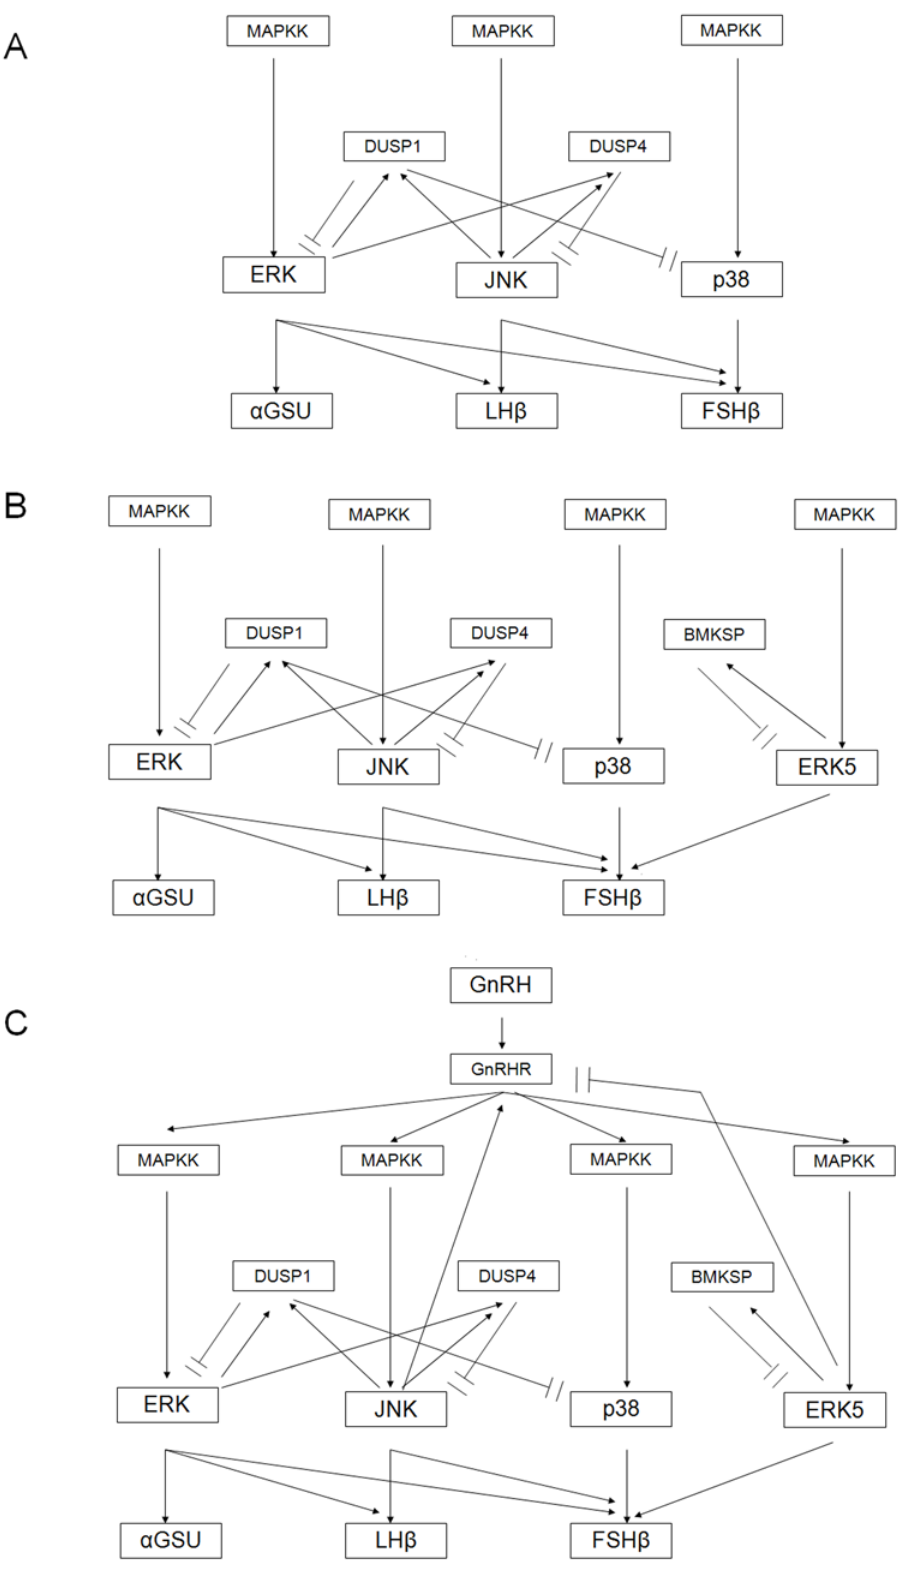
Figure 8. Schematic representation of the models used. The (A) basic, (B) intermediate and (C) full models used in examining the effect of different feedbacks on the decoding of GnRH pulse frequencies for differential gonadotropin subunit-gene expression are shown. Arrows indicate activation (in the case of enzymatic reactions) or induction (in the case of genes). Analogously, barheads indicate de-activation (enzymatic reactions) or repression (gene expression).